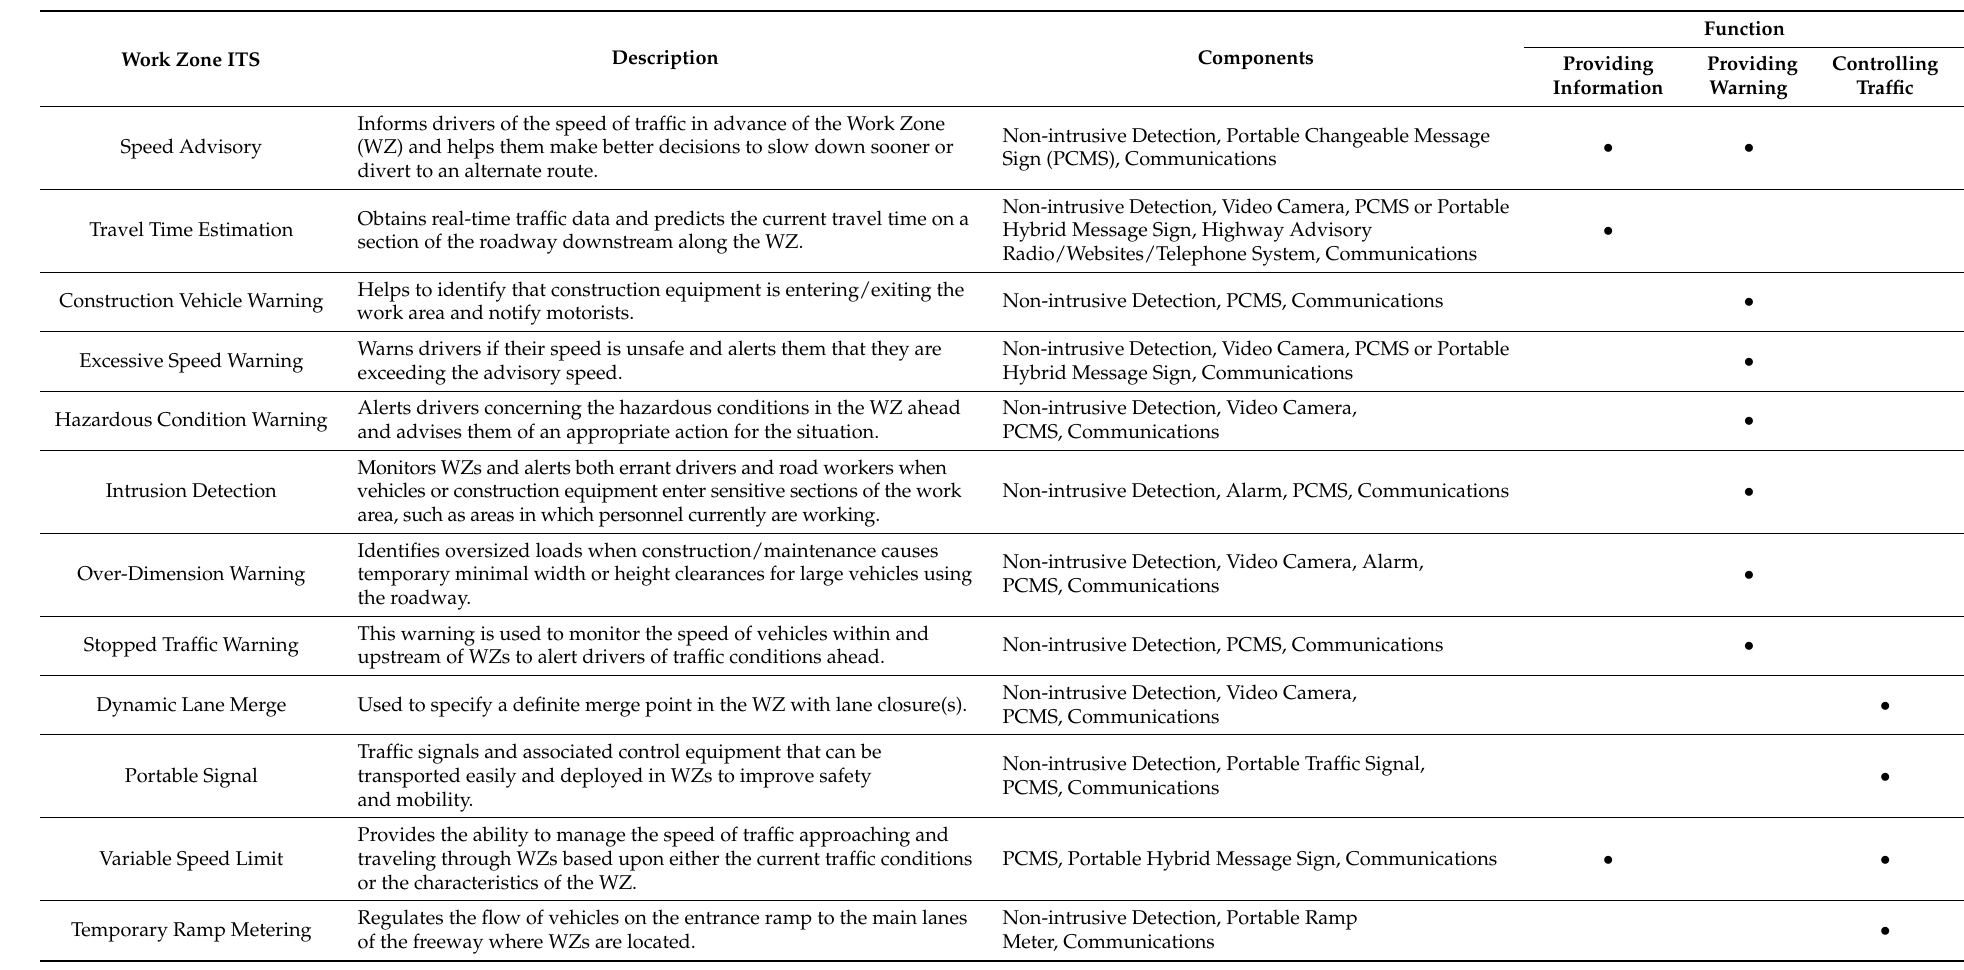
Table 1. Work zone ITSs, components, and